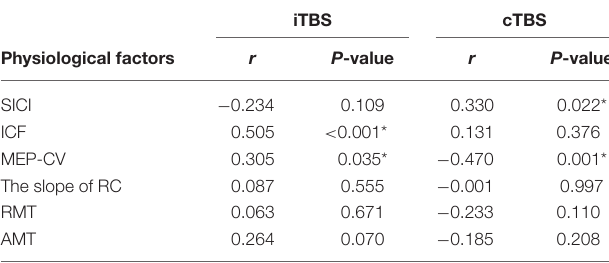
TABLE 1 | Correlation between MEP response to each TBS and the physiological factors at the baseline and effects of each